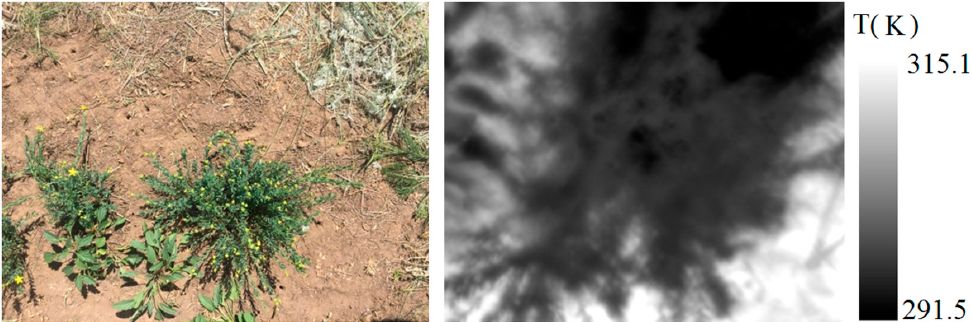
Figure 13. Temperature of Haplophyllum dauricum retrieved from the HTIR dataset.